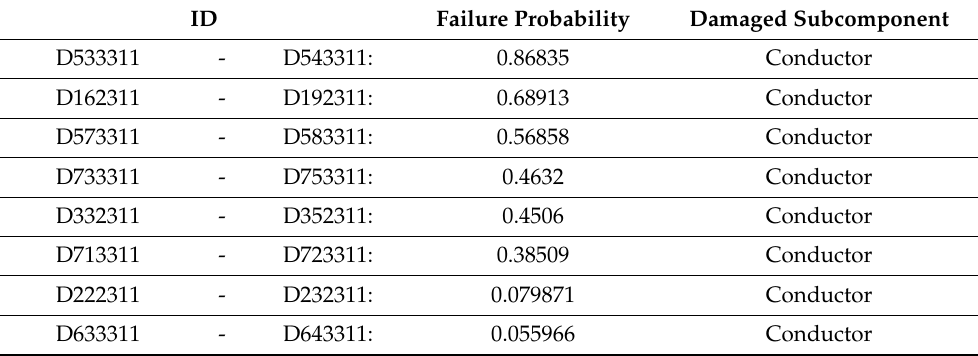
Table 4. List of critical components with the relevant failure probabilities over 10 min, case